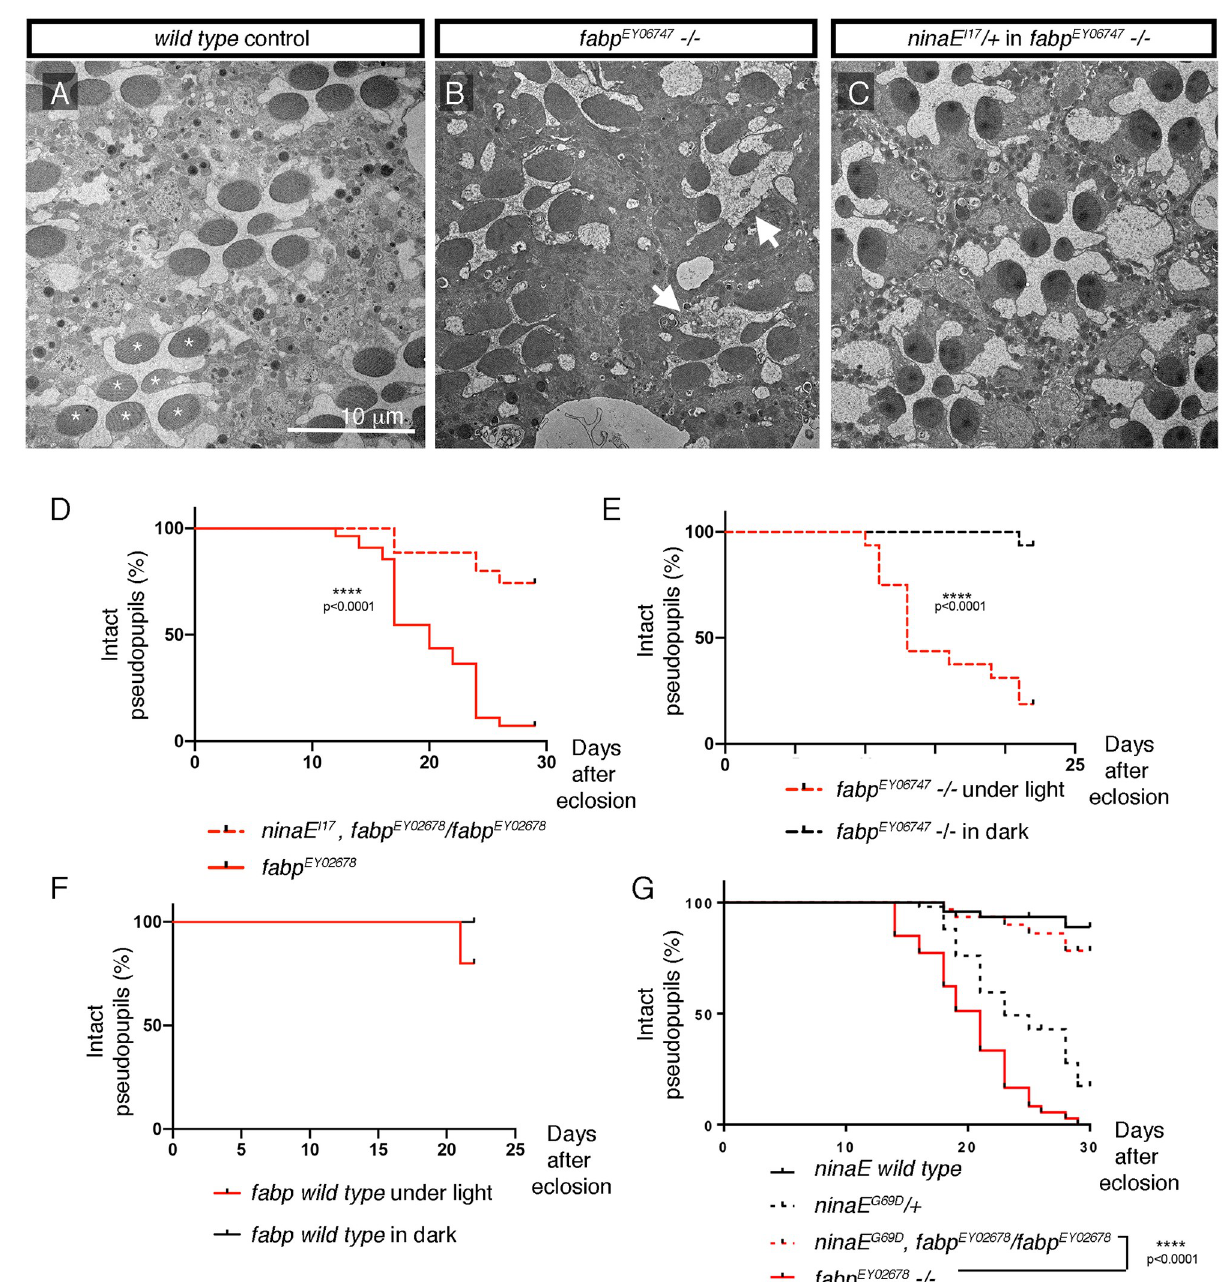
Fig 7. Retinal degeneration in fabp loss of function mutants. (A-C) Representative Transmission Electron Microscopy (TEM) images of adult fly ommatidia of the indicated genotypes. Flies were reared under 1000 lux constant light. (A) ninaE wild type control. Asterisks mark the seven rhabdomeres arranged in a trapezoidal pattern within a single ommatidium. Scale bar = 10 μ m. (B) fabp EY06747 -/- ommatidia from a 27 day-old fly raised under light. Two ommatidia on the right have less than seven rhabdomeres (white arrows), indicative of retinal degeneration. (C) Ommatidia of fabp EY06747 -/- flies in the ninaE I17 /+ background, also of 27 day-old flies, raised under light. (D, E) The course of retinal degeneration in flies of the indicated genotypes, assessed through Rh1-GFP pseudopupils. The y axis shows % of flies with intact photoreceptors. The x axis indicates the days after eclosion. (D) fabp EY02678 mutant flies had accelerated retinal degeneration (solid red line), which was suppressed when one copy of ninaE I17 loss-of- function mutant was introduced into the background (dotted red line, p < 0.0001, Log-rank test). (E) The course of retinal degeneration of fabp EY06747 -/- when reared under 1000 lux of constant light (red dotted line), or reared under constant darkness (black dotted line). p < 0.0001. (F) fabp wild type control flies reared under constant light (red solid line) or under constant darkness (black line). No statistical significance found (Log rank test). (G) The course of retinal degeneration in fabp EY02678 mutant flies was also significantly delayed in the ninaE G69D /+ background (p < 0.0001, Log-rank test), even though ninaE G69D /+ mutants showed age-related retinal degeneration phenotype on its own.